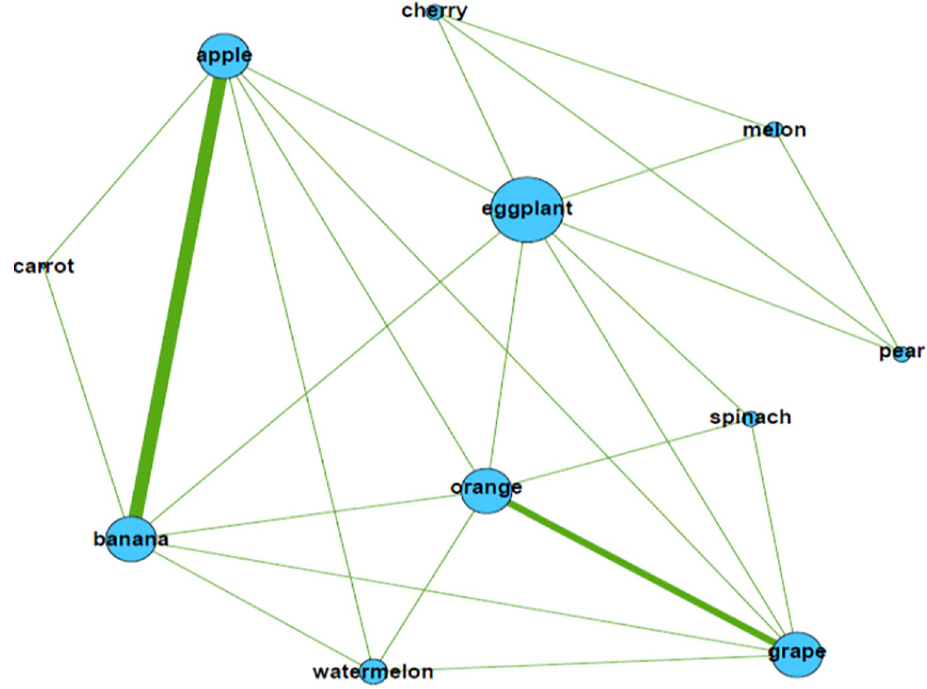
Fig 1. Word network of DocA. � The size of a node refers to the degree of the node, whereas the width of a tie between two nodes refers to the weight of the tie.